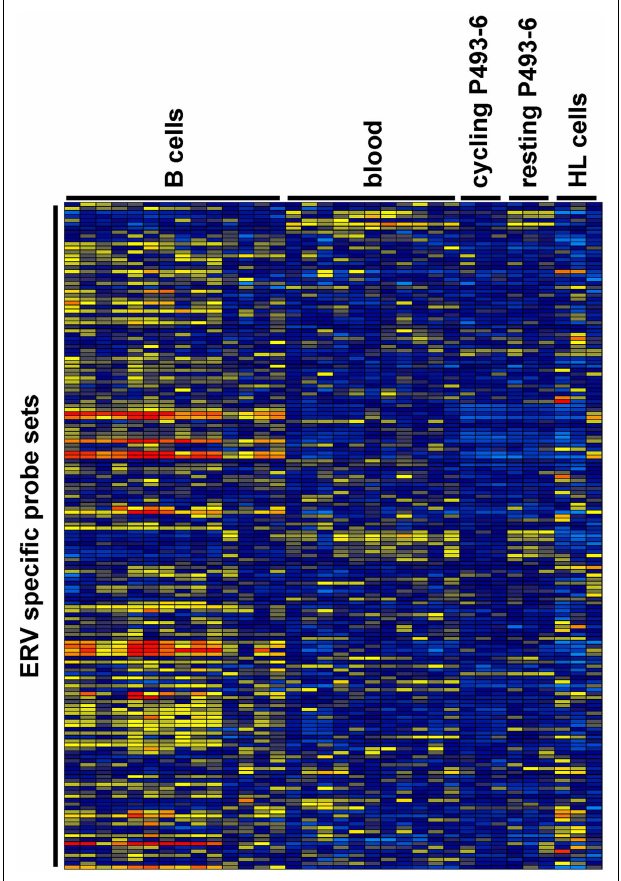
FIGURE 1 | Heat map of ERV-specific probe sets in the investigated DNA microarray data . Probe sets with specificity for ERV-related sequences were selected from microarray data from normal blood cells [GEO data set GSE18838 (40)], normal B cells [GEO data sets GSE14352 and GSE5188 (42, 43)], P493-6 cells [GEO data set GSE32219 (41)], and HL cell lines. Signal intensities were visualized using the Genesis software (log2-transformed and mean centered data).The used arrays contain probe sets for the following ERV: ERV3-1 , ERV3-2 , ERV9-1 , ERV18-1 , ERVFC1-1 , ERVFH21-1 , ERVFRD-1 , ERVFRD-2 , ERVH-1 , ERVH-4 , ERVH-6 , ERVH48-1 , ERVI-1 , ERVK3-1 , ERVK3-2 , ERVK-6 , ERVK-7 , ERVK-9/-4/-19 , ERVK11-1